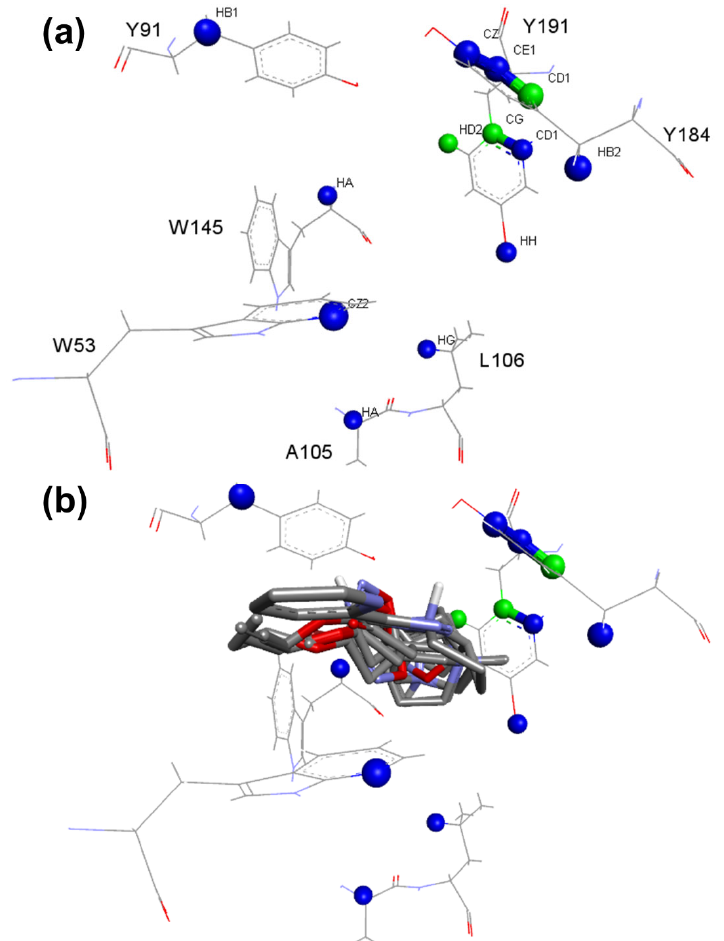
Figure 7. Critical contacts from α 7 receptor dbCICA analysis ( a ) and most well-behaved ligands from dbCICA analysis overlay ( b ). ( a ) Positive contacts from α 7 receptor dbCICA model are shown in green and negative contacts are shown in blue. ( b ) Superposition of the best well-behaved ligands from dbCICA analysis (see ligands 2 , 17 , 18 , 19 , 20 , 21 , 22 , 23, and 24 in Figure 9). Carbon atoms are shown in gray, nitrogen atoms in blue, oxygen atoms in red and hydrogen atoms in white. The atoms were automatically named by the Discovery Studio Visualizer software, and the residue numbering respects the originally published numbering from PDB structure. Only polar hydrogens from ligands are shown.